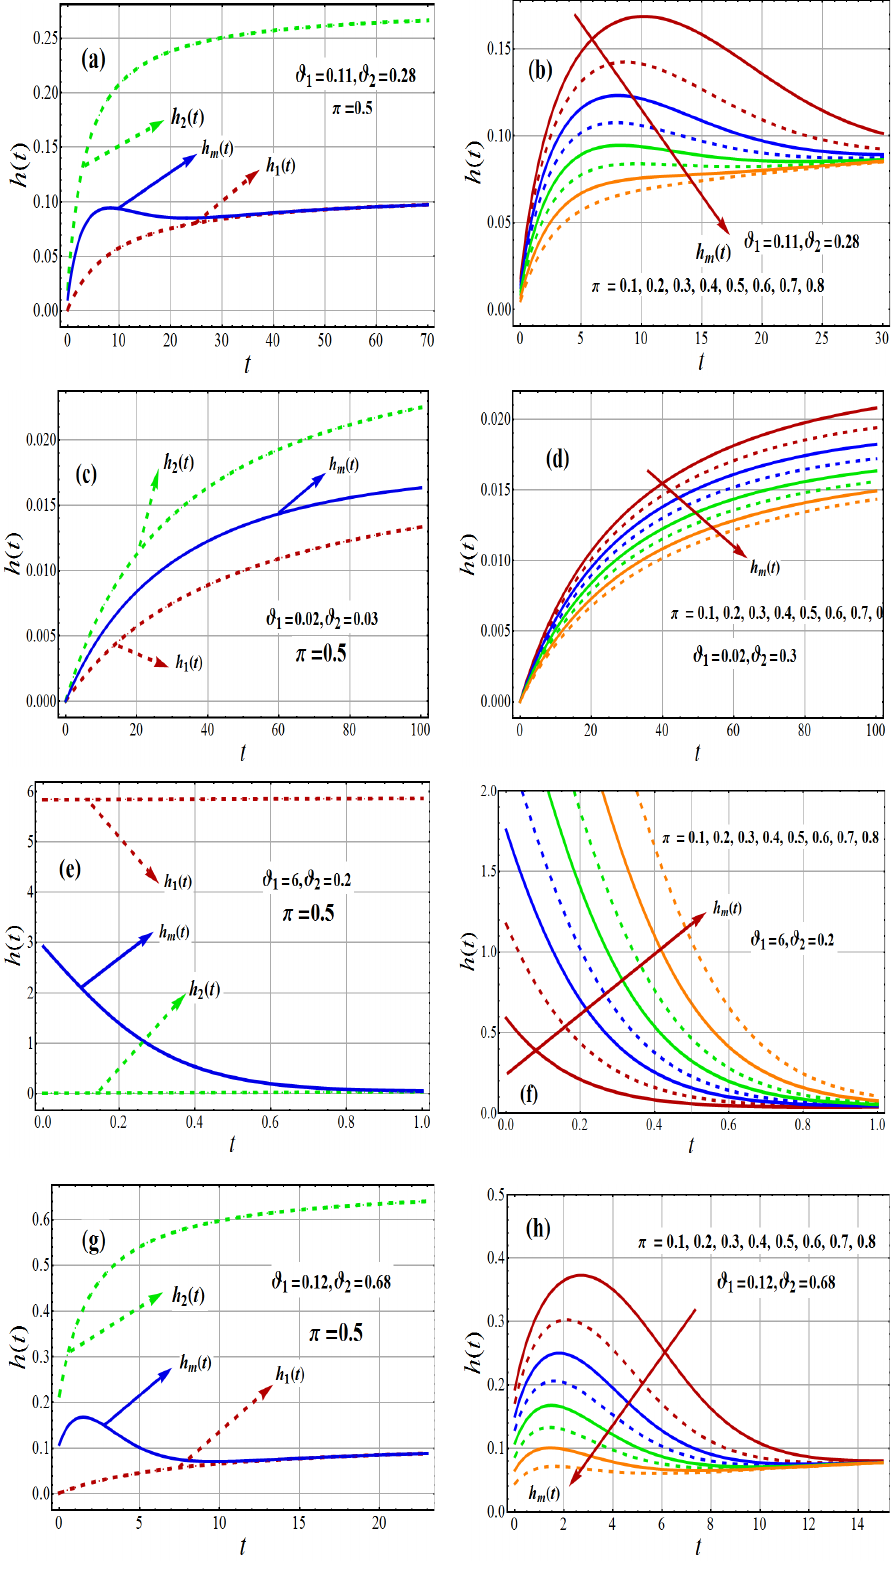
( t ) ; h ( t )) and hrf of 2-CMSM ( h 1 2